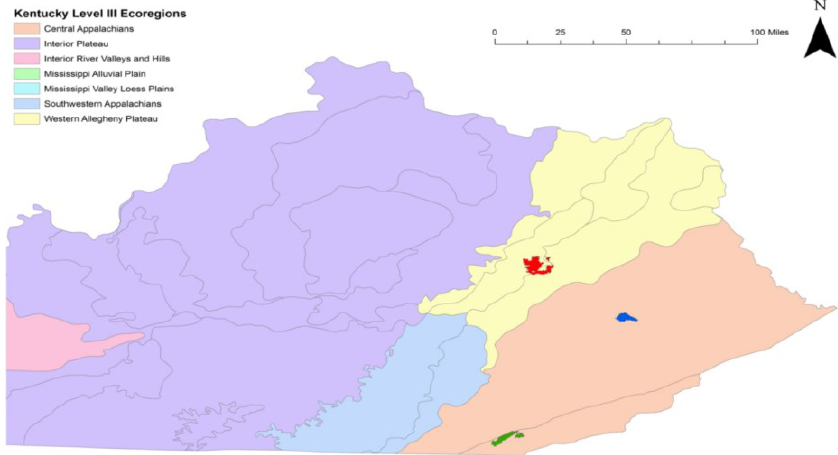
Figure 1. Location of sites in the Cumberland Plateau physiographic province of eastern Kentucky (USA) used to evaluate effects of dominant riparian vegetation on benthic collectors and grazers, including Red River Gorge ( ), Robinson Forest ( ), and Kentucky Ridge State Forest (